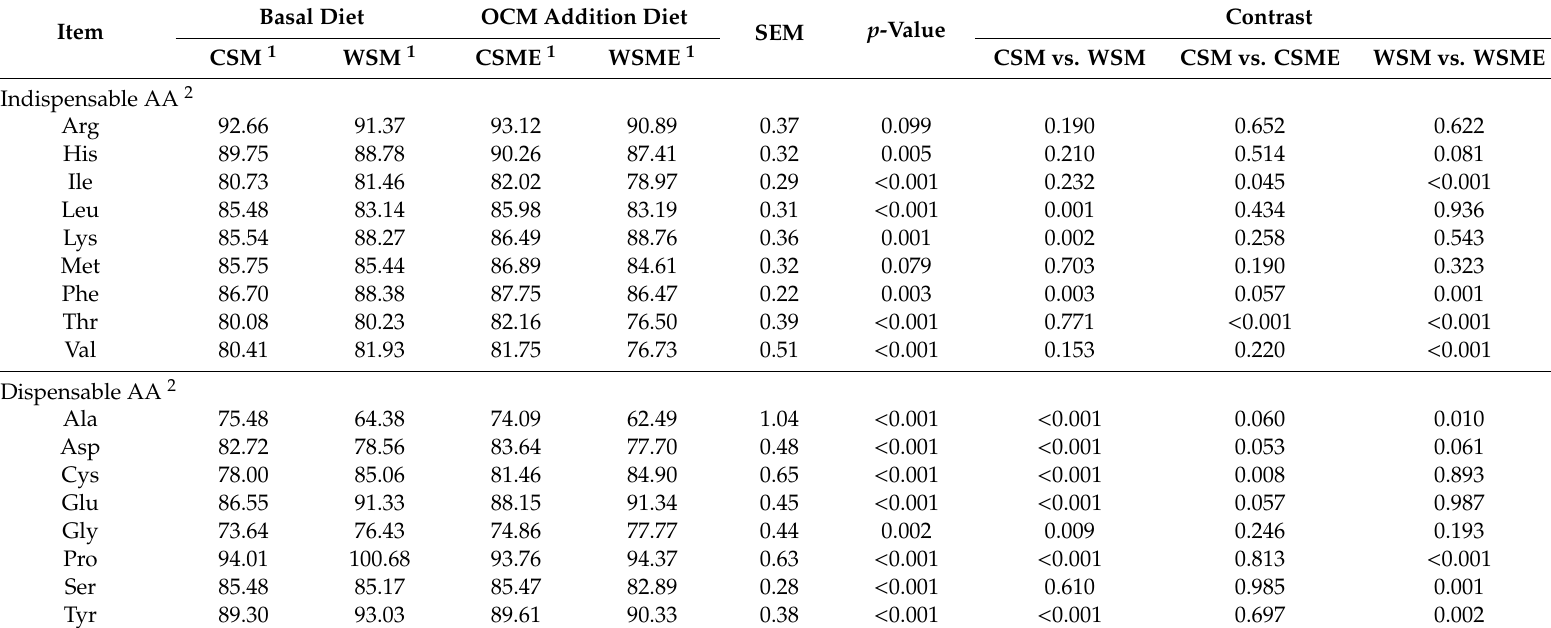
Table 8. E ff ects of the optimal carbohydrase mixtures on standard ileal digestibility of amino acids in growing pigs fed two types of diets,